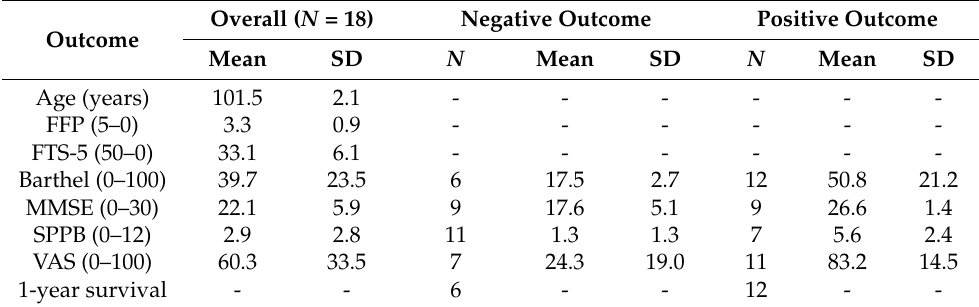
Table 2. Outcome measures (mean and SD) for the overall group and for each dichotomized group according to health